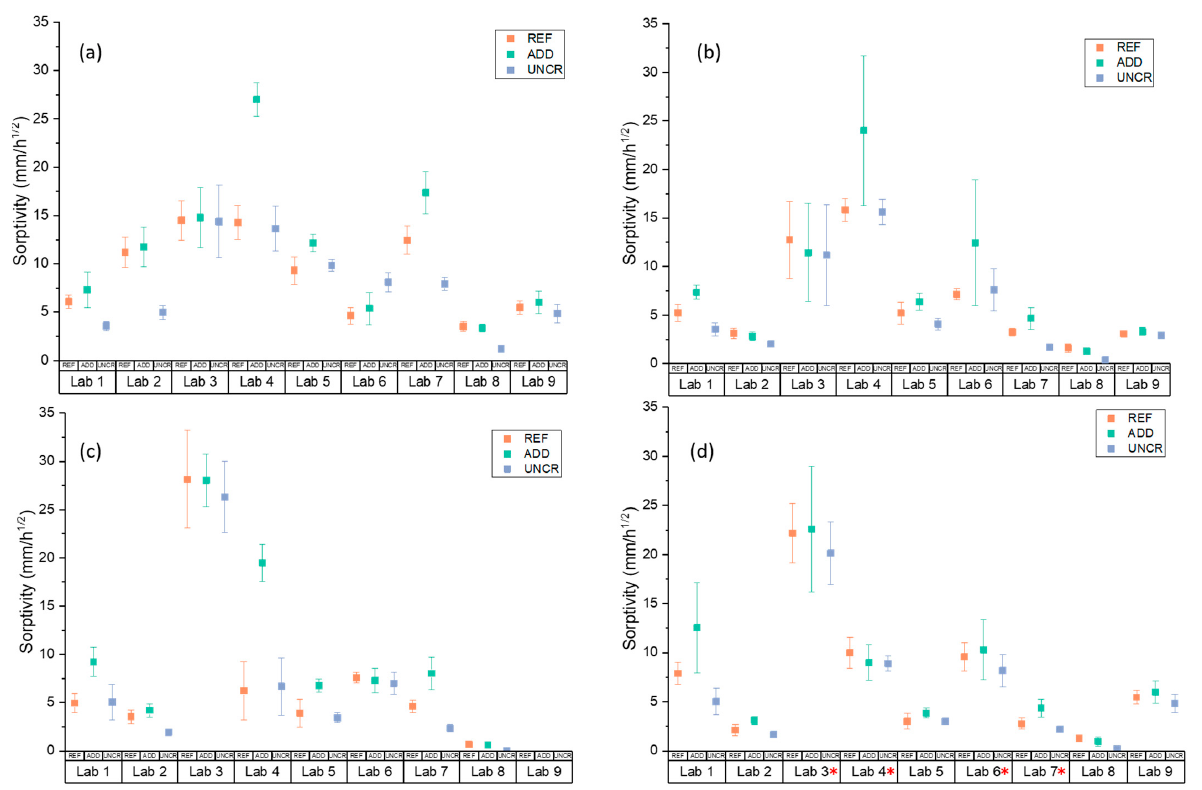
Figure 11. Sorption coefficients of REF, ADD, and UNCR specimens at different time intervals: ( a ) after (time 0) and after ( b ) 1 month, ( c ) 3 months, and ( d ) 6 months of healing. Error bars indicate the standard deviation. * denotes a longer healing period adopted.